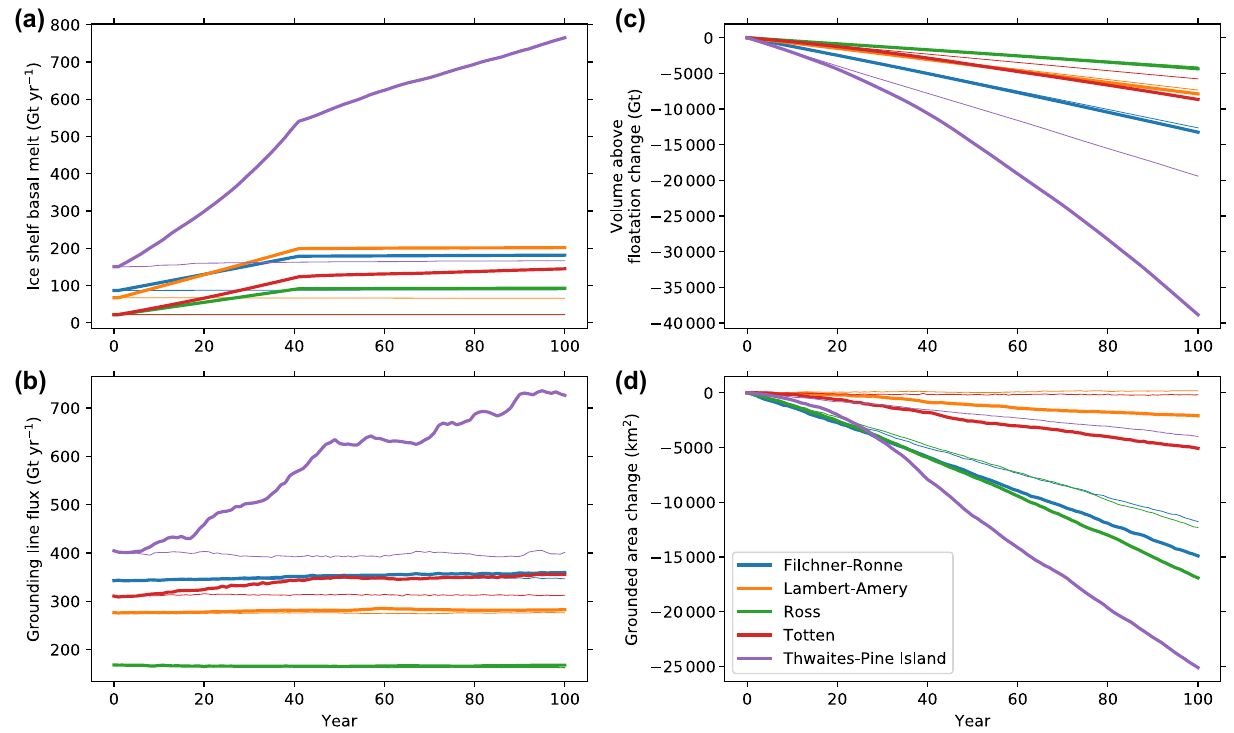
Figure 14. Model results for initMIP control (thin lines) and sub-ice-shelf melt perturbation (thick lines) experiments for selected drainage basins. Basins are composed of their respective ice shelves and the IMBIE basins (Shepherd et al., 2012) flowing into them from upstream. (a) Total ice shelf basal melt; (b) total flux across grounding line; (c) change in volume above floatation from initial time; (d) change in grounded area from initial